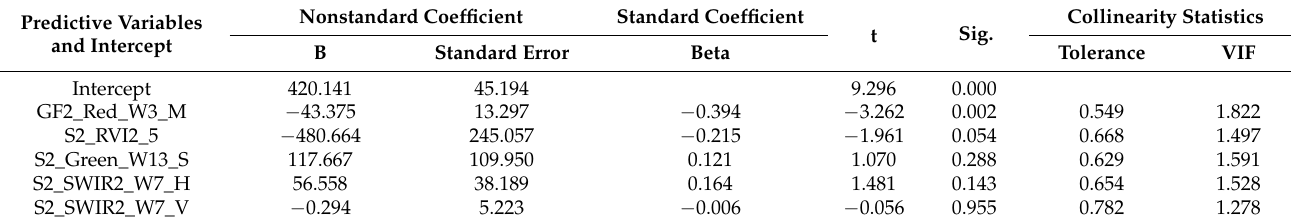
Table 8. Multiple regression analysis of feature variables selected by AFCO-RFR method for integrated GF-2 and Sentinel-2 datasets. The dependent variable is GSV. Sig., Significance, VIF, and variance inflation factor. Predictive Variables and